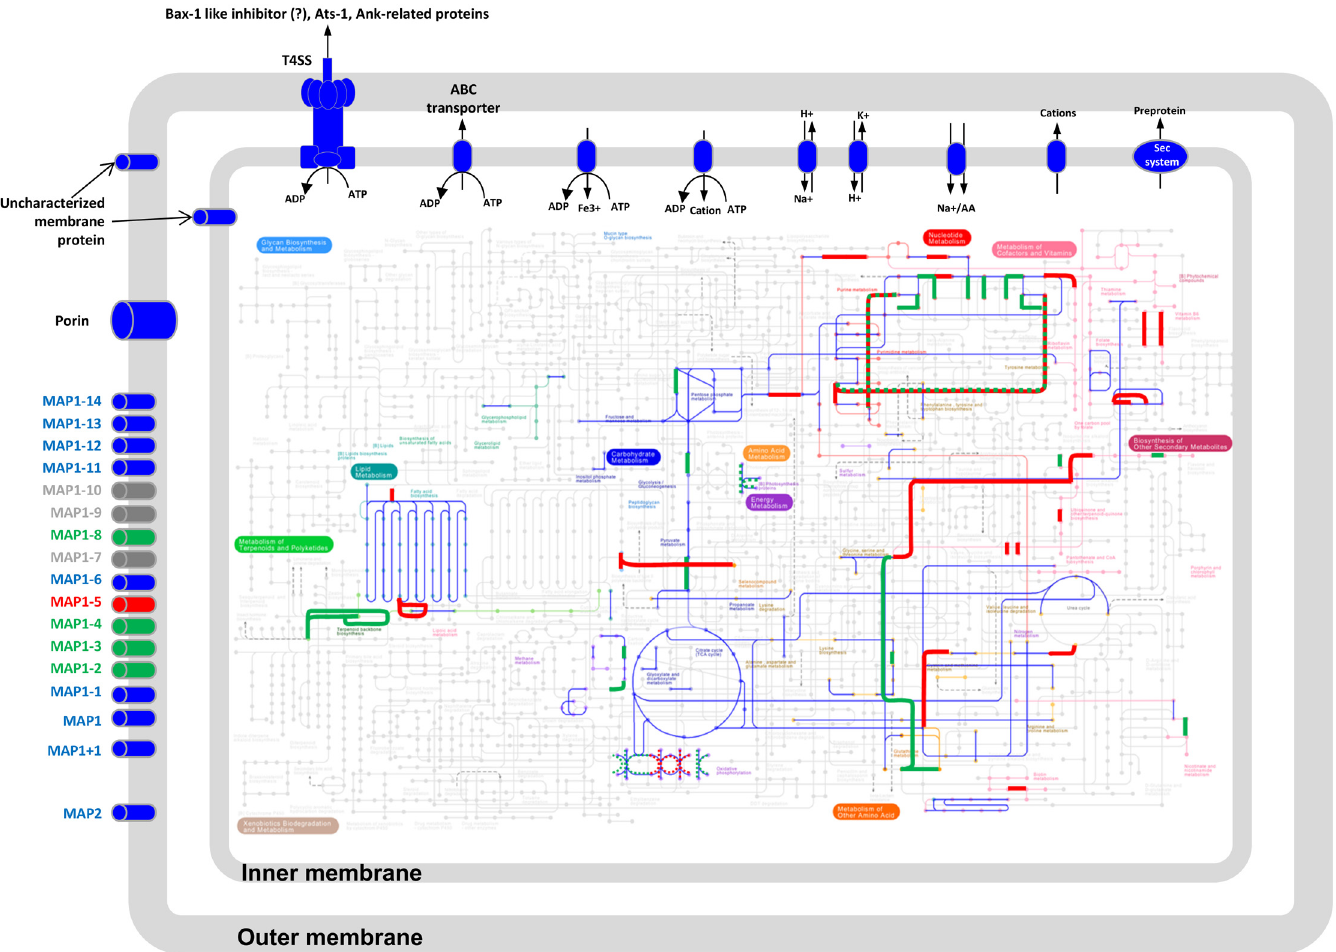
Fig 4. Schematic overview of metabolic pathways and membrane proteins found in ERG, based on genomic (KEGG database) and proteomic information obtained in this work. Nodes correspond to substrates and edges to enzymatic reactions and the 11 major metabolic pathways are color- coded (for example, light orange for amino acid metabolism). The proteins that were identified on both ERGvir and ERGatt are indicated in dark blue, the proteins and pathways found exclusively in ERGatt are in red and those detected only in ERGvir are highlighted in green. The dashed lines correspond to metabolic pathways found in both